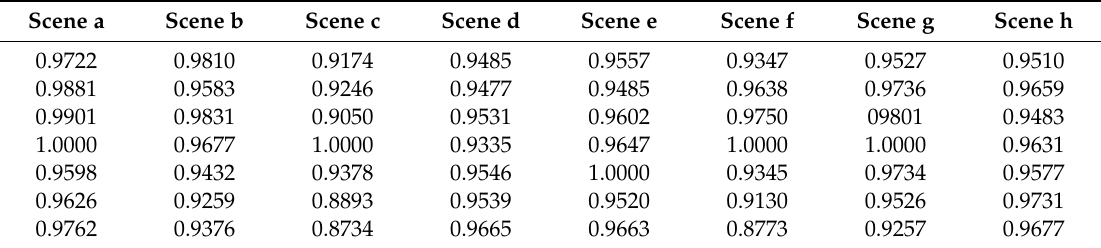
Table 5. The change of the entropy function during focusing in different scenes. Scene a Scene b